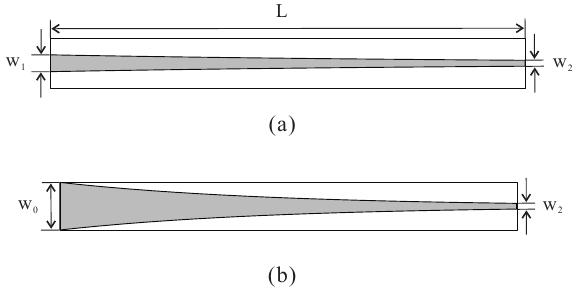
Figure 4. Geometry of the proposed balun: ( a ) Top side; ( b ) Bottom